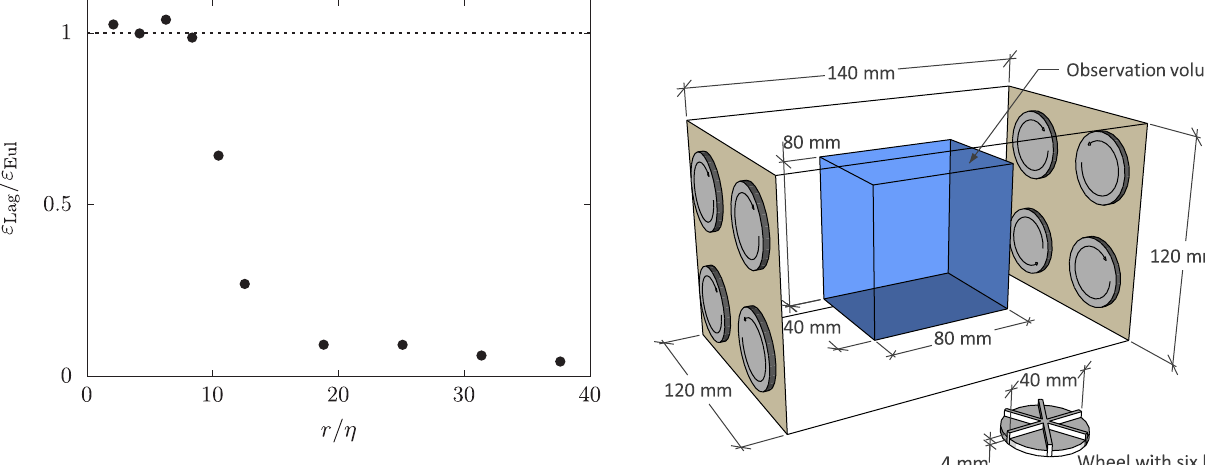
FIG. 5. Turbulent dissipation rate (plotted as the ratio between the Lagrangian and Eulerian measurement) as a function of the separation distance r normalized with the Kolmogorov length scale η .